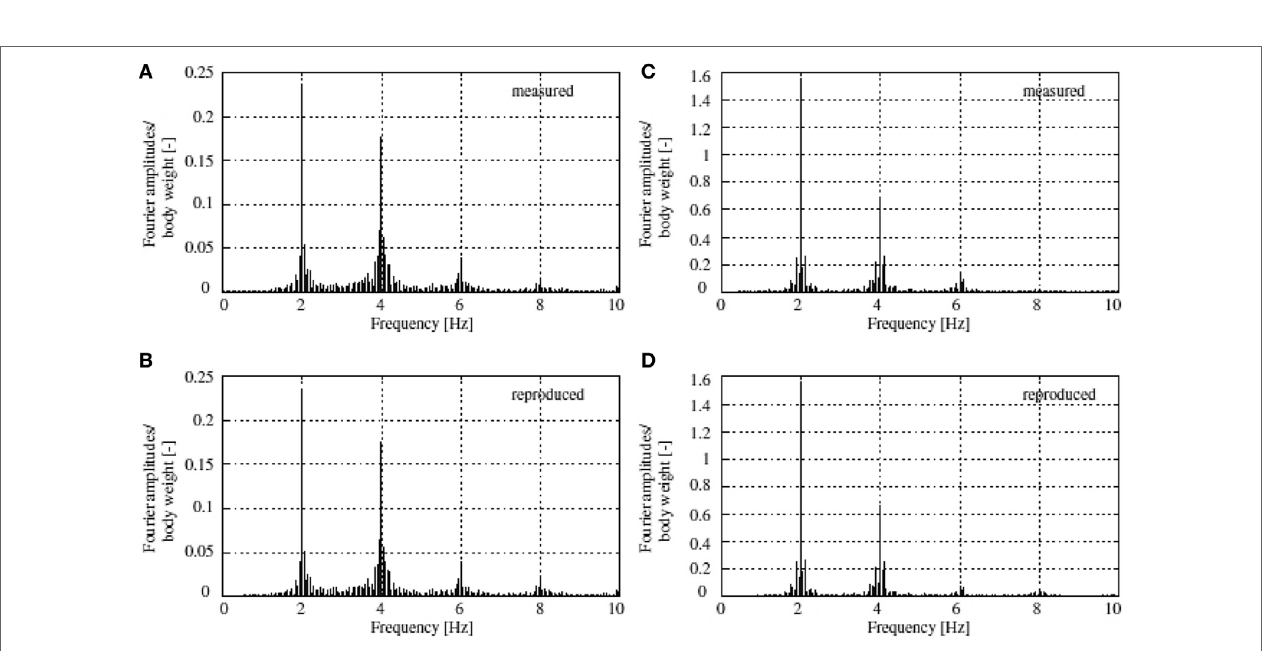
FiGURe 4 | Comparison between directly measured and reproduced (A,B) bouncing and (C,D) jumping forces in the frequency domain. Each Fourier amplitude was derived from a single 20-s long force signal without the use of averaging. Reprinted from (Racic et al., 2010a) with permission from